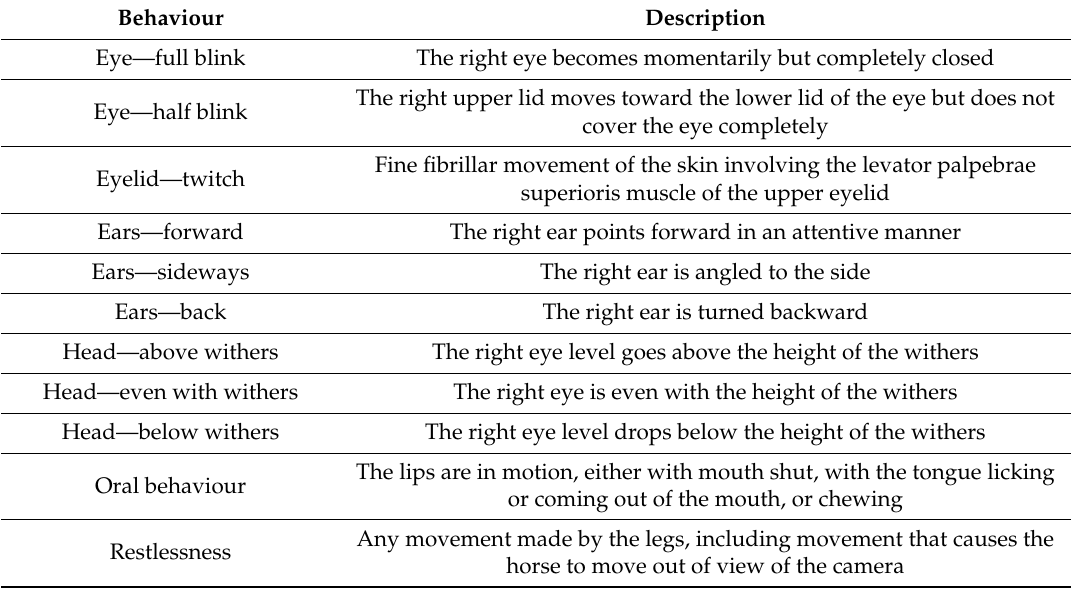
Table 1. Ethogram of behaviours observed in horses ( n = 33) during each of the four treatments—control, feed restriction, separation from conspecifics and the startle test. Adapted from [13,25,30,31].